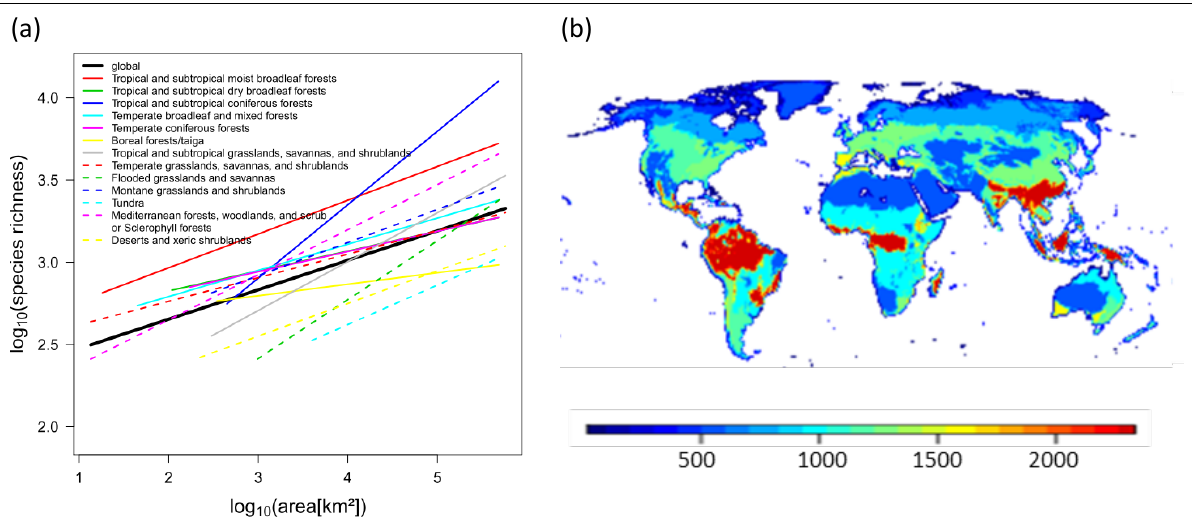
Figure 1. (a) Differences in species–area relationship (SAR) curves for vascular plants among biomes. Axes delineate ranges of original data (see Fig. 1b). The lengths of SAR curves reflect the range sizes of sampling units used to fit the relationship. The thick black line indicates the global relationship. (b) Predictions of vascular plant species richness for 100 km x 100 km grid cells based on my biome-specific SAR. Figure reproduced with publisher’s permission from Gerstner et al.